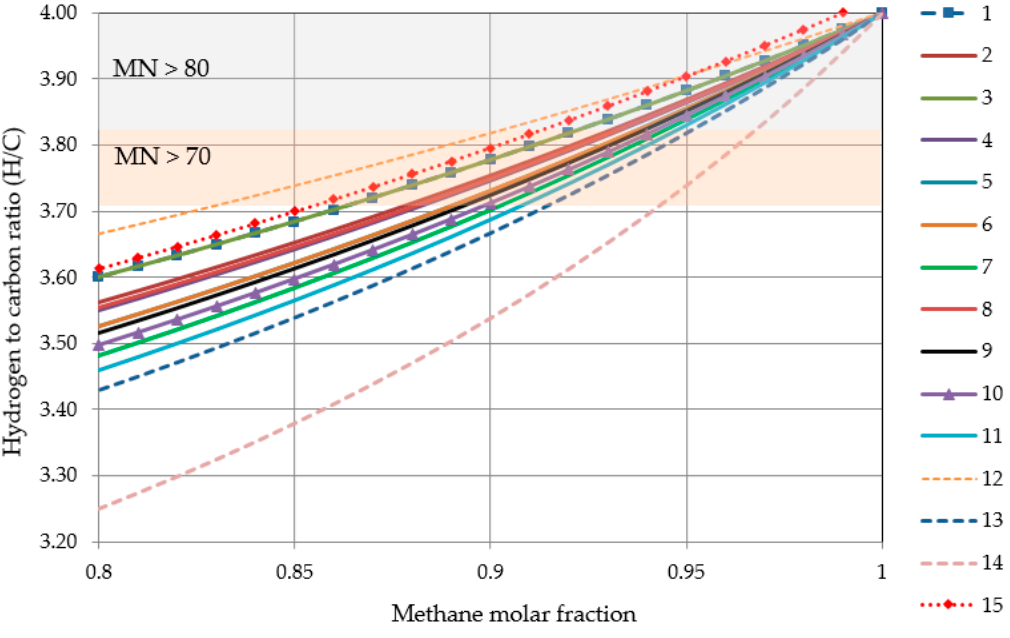
Figure 6. Hydrogen to carbon ratio vs. molar fraction of methane for assumed LNG compositions sets.